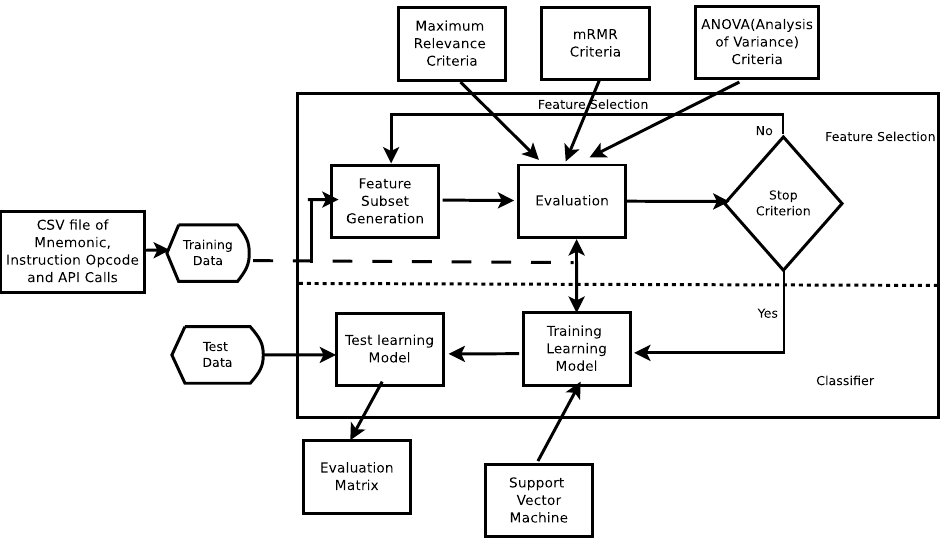
Figure 3. Feature selection